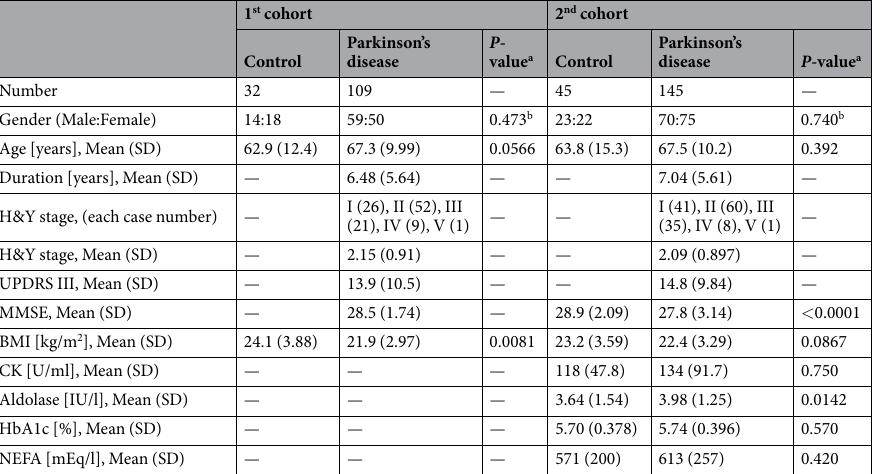
Table 1. Participants’ characteristics. Abbreviations: SD = standard deviation; H&Y stage = Hoehn and Yahr stage; UPDRS = Unified Parkinson’s Disease Rating Scale; MMSE = Mini Mental State Examination; BMI = Body Mass Index; CK = creatine kinase; ALD = aldolase; HbA1c = hemoglobin A1c; NEFA = non- esterified fatty acid. a P -value obtained by analysis of covariance between controls and PD. b P -value obtained by chi-squared